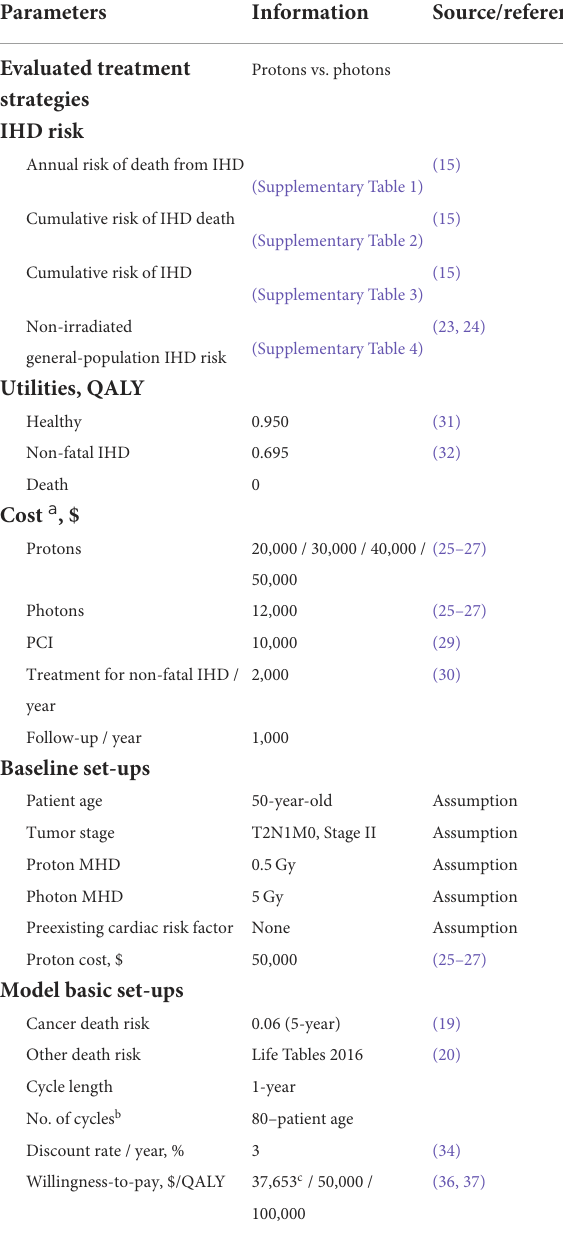
TABLE 1 Model information and